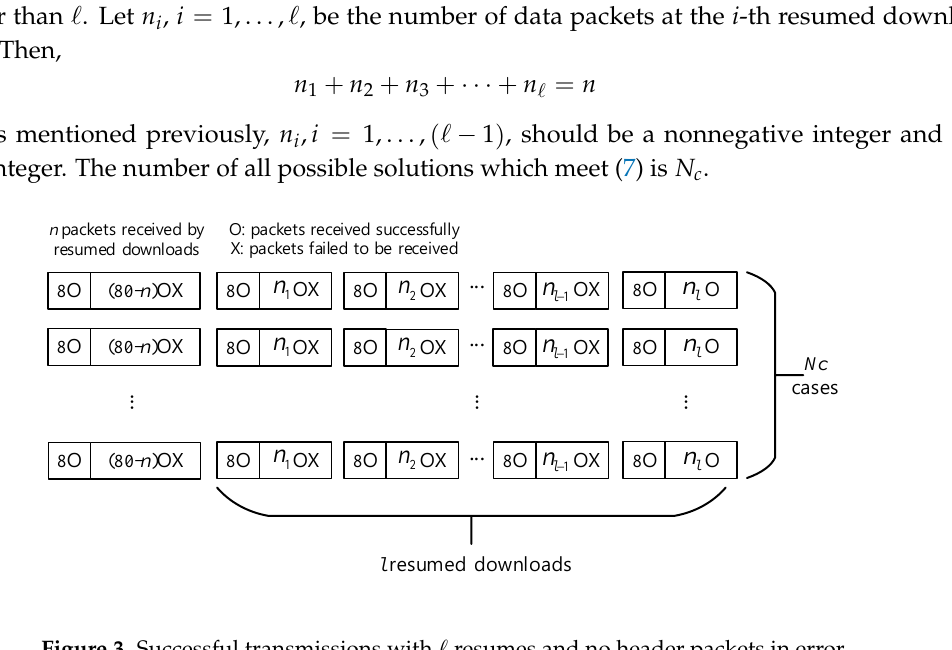
Figure 3. Successful transmissions with (cid:96) resumes and no header packets in